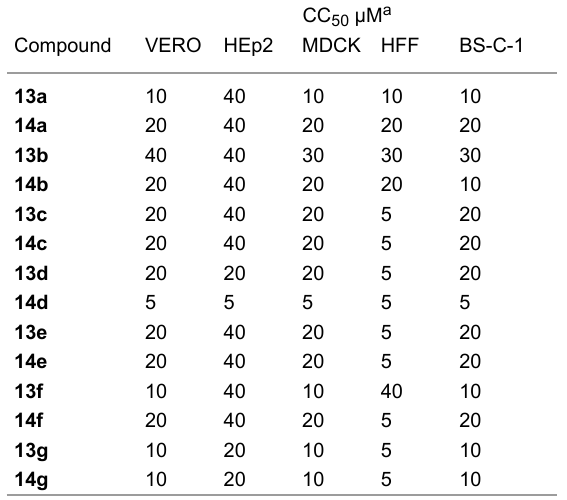
Table 2: Biological activity of C-5’-triazolyl-2’-oxa-3’-aza-4’a-carbanu- cleosides 13a–g and 14a–g